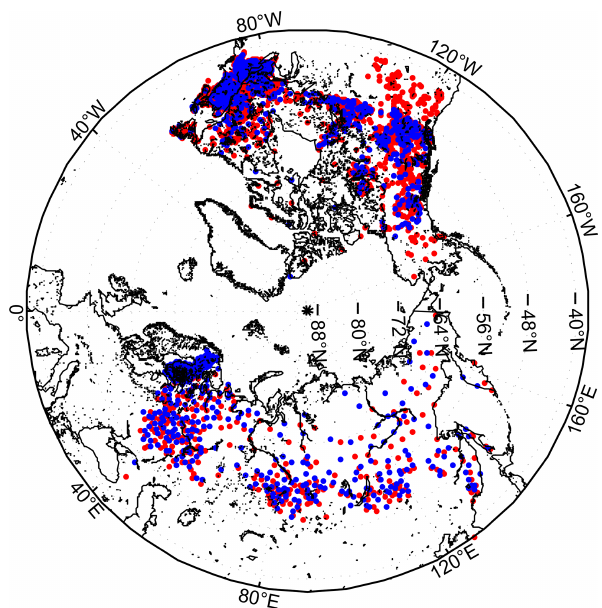
Figure 1. Snow density and SWE measurement locations. Imple- mentation (red) and validation (blue) data are